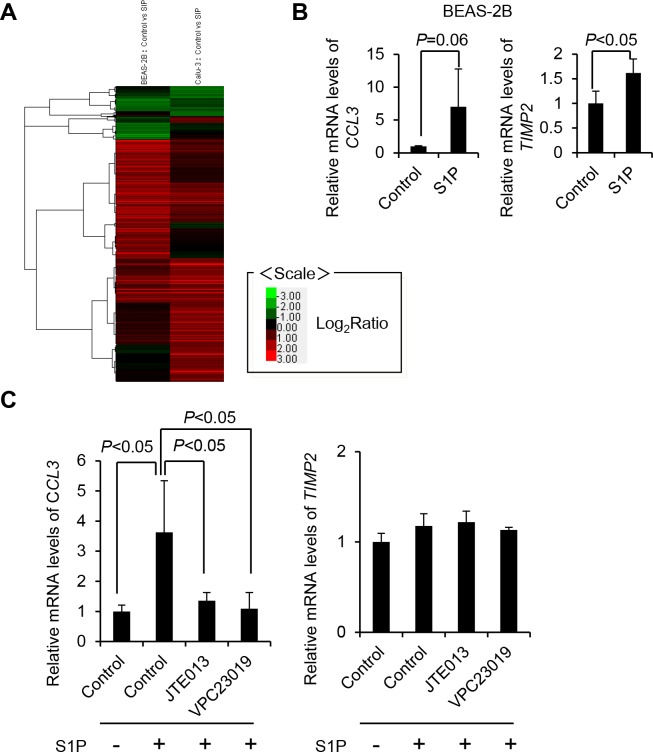
A hierarchical cluster analysis performed with Pearson’s correlation coefficient using log2 ratio data and qRT-PCR analysis of CCL3 and TIMP2.BEAS-2B and Calu-3 were stimulated with or without S1P (1 μM) for 2 h. Total RNA labeled with Cy3 or Cy5 was hybridized to a 3D-Gene Human Oligo chip 25 k (n = 1). Genes with Cy3/Cy5 normalized ratios greater than 2.0 were identified. A total of 967 genes that were upregulated to more than 2-fold or downregulated to less than 2-fold in at least 1 pair were analyzed (A). Relative mRNA levels of CCL3 and TIMP2 were analyzed by qRT-PCR in BEAS-2 (B) and Calu-3 (C).